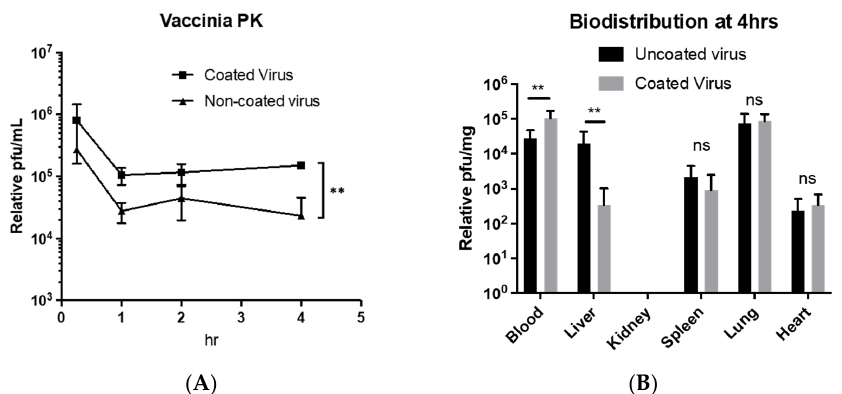
Figure 6. ( A ) Acute pharmacokinetics of an intravenously administered dose of coated and uncoated oncolytic vaccinia virus. ( B ) Biodistribution of the coated and uncoated oncolytic vaccinia viruses in blood and in several organs 4 hours post-intravenous administration. The results are presented as mean ± SD, n = 6. Data were analyzed with Student’s t -test. The level of statistical significance was set at probability level ns p ≥ 0.05, ** p < 0.01.